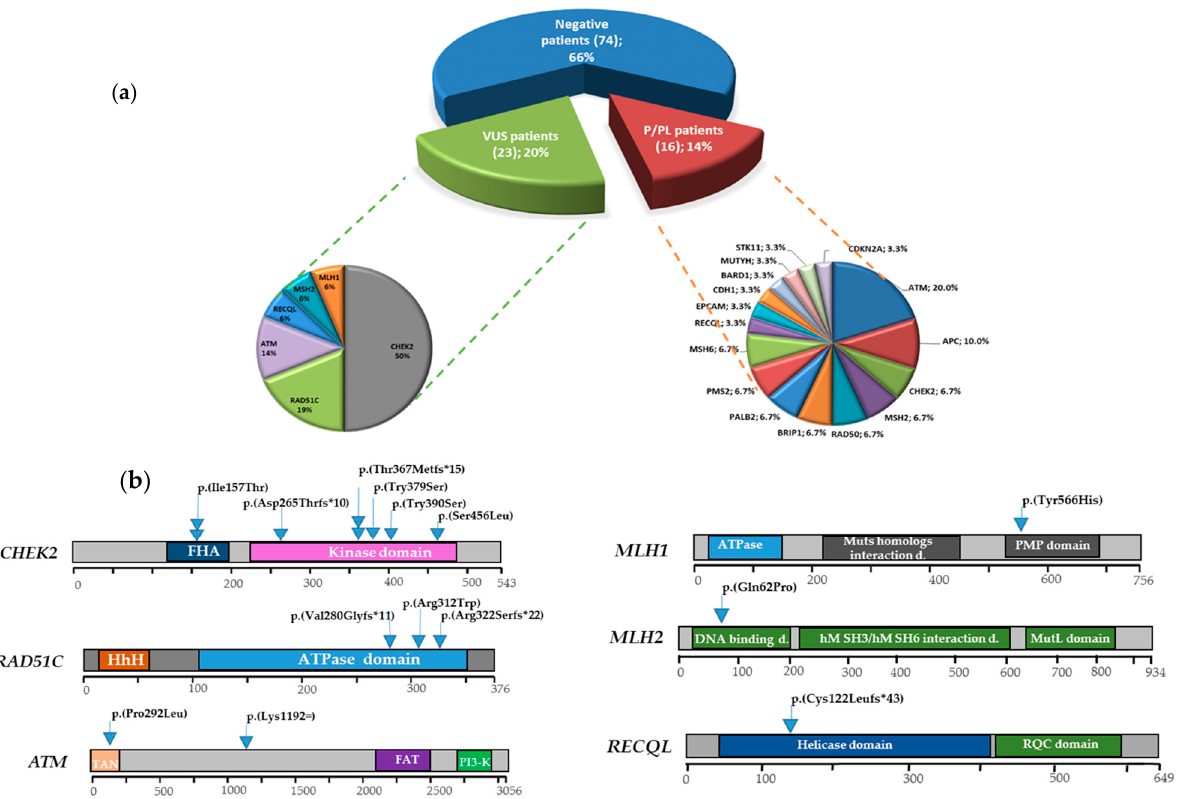
Figure 1. Distribution of patients with and without P / LP (P, pathogenic, LP, likely pathogenic variants). ( a ) Sixteen out of 113 patients were identified with P / LP variants. ( b ) Schematic representation of the CHEK2 , RAD51C , ATM , MLH2 , MLH1 , RECQL genes and positions of identified P / LP variants. FHA: Fork-head-associated domain; HhH, helix-hairpin-helix motif; TAN, Tel1 / ATM N-terminal motif; FAT, FRAP-ATM-TRRAP domain; PIKK or PI3K, phosphatidylinositol 3-kinase-related kinase domain; PMP, PMS2 / MLH3 / PMS1 interaction domain; Muts, DNA-binding domain of DNA mismatch repair; RQC, RecQ carboxy-terminal domain.